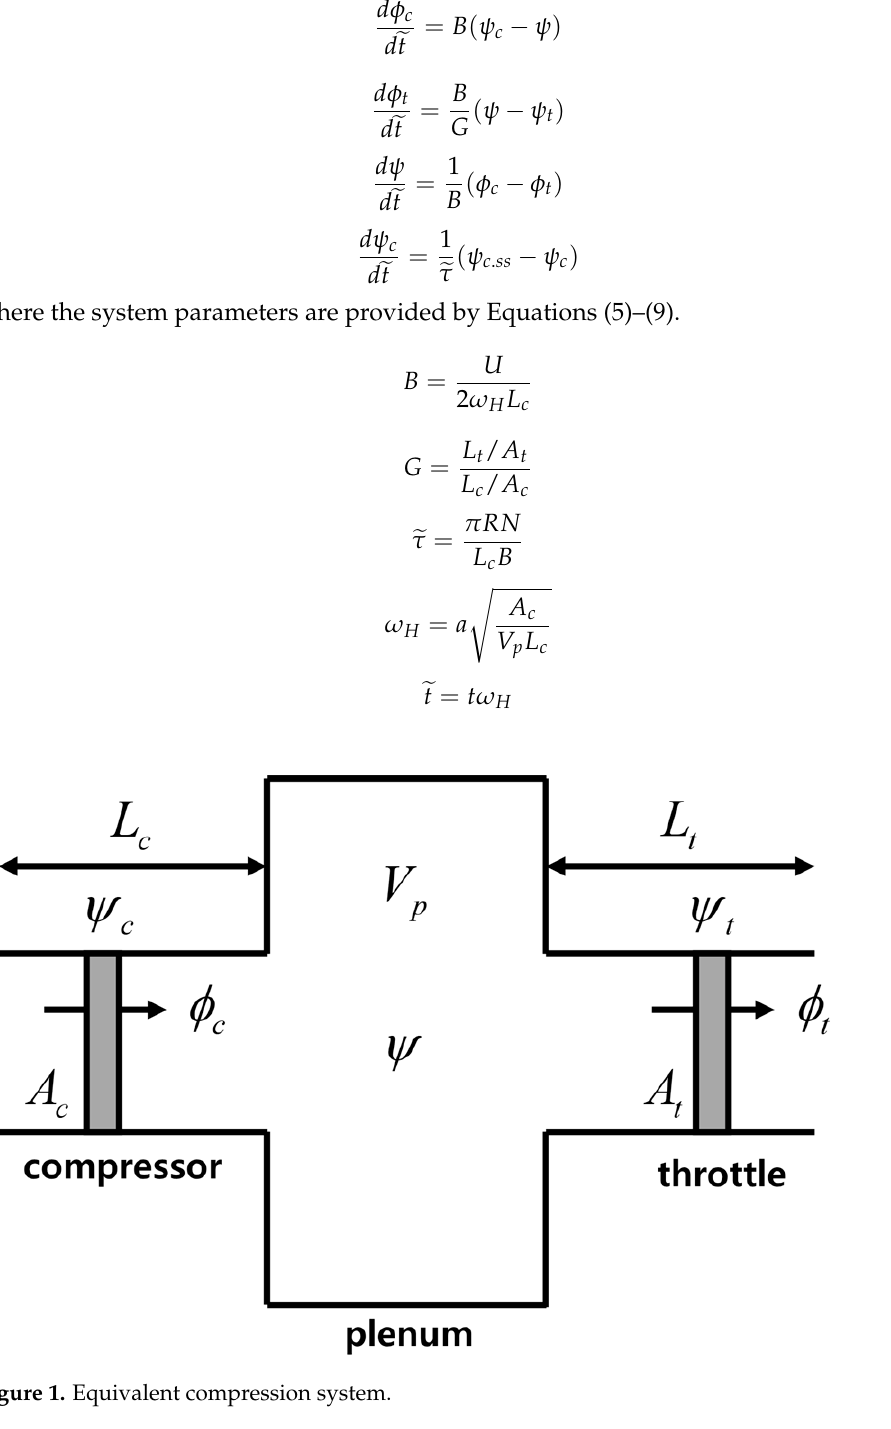
Figure 1. Equivalent compression system. Table 1. Geometrical parameters of the compression system and